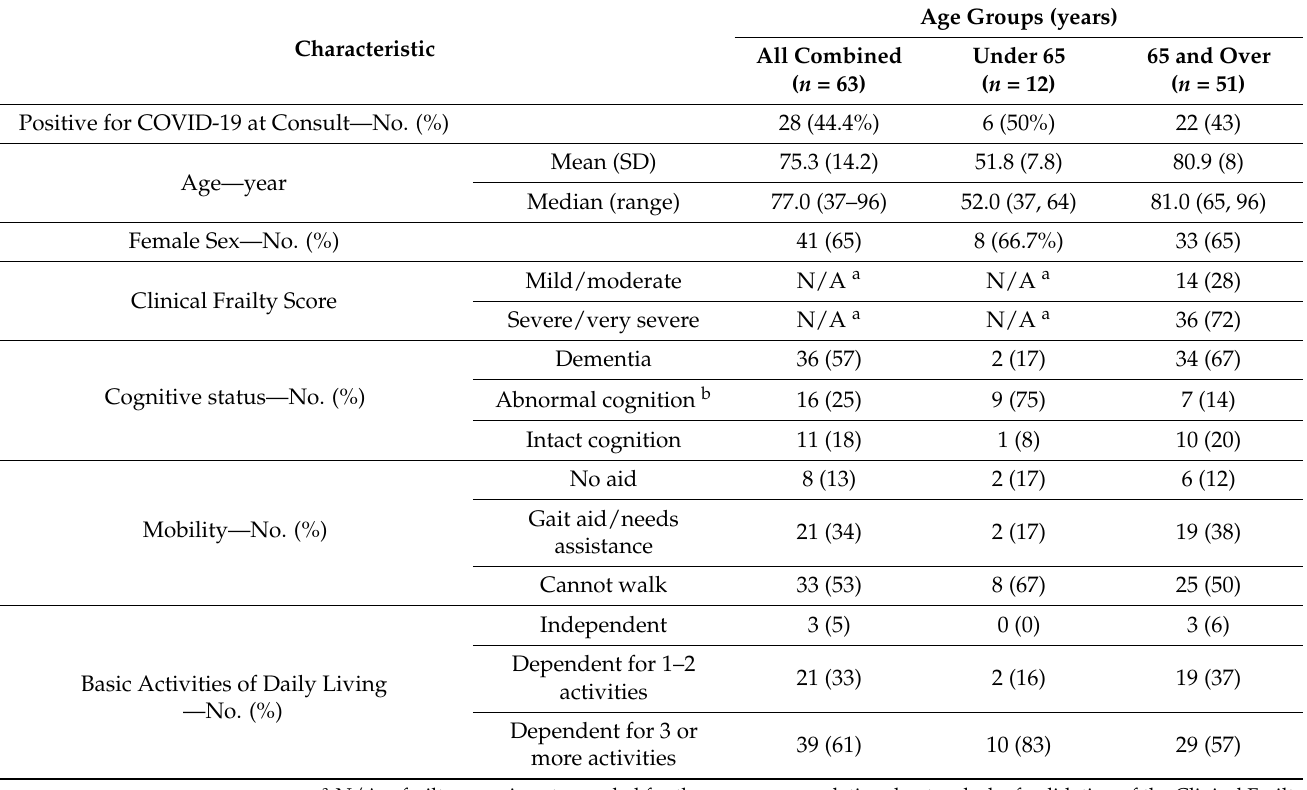
Table 1. Characteristics of long-term care residents.